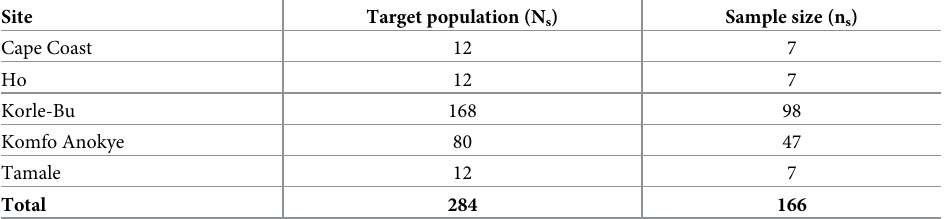
Table 1. Estimated sample size per